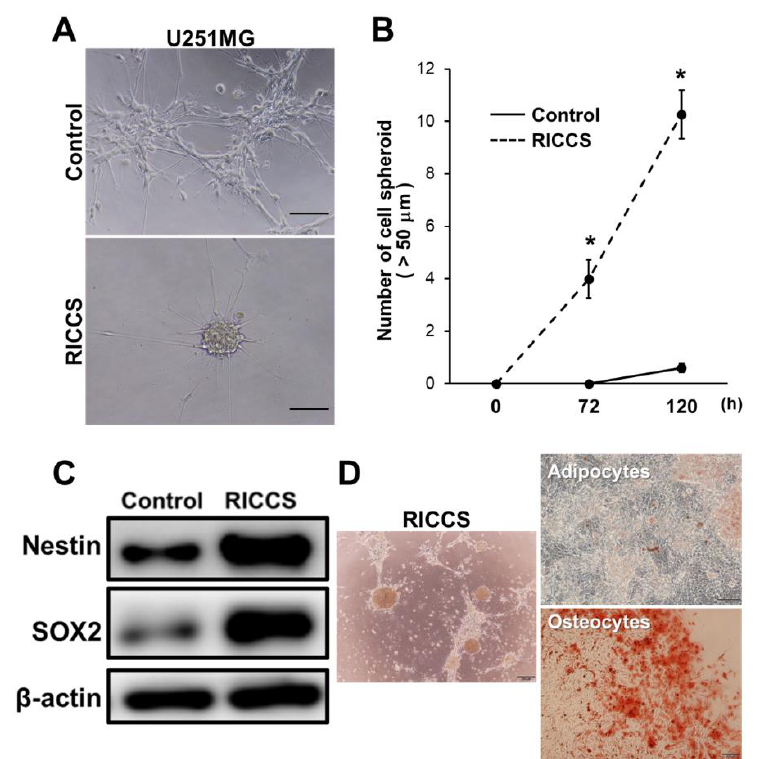
Figure 1. Ribosome incorporation into glioma cells induced stem cell characters. ( A ), Control (PBS) or ribosome-induced cancer cell spheroid (RICCS) in GBM (U251MG) cells. ( B ), Stem cell character was confirmed by sphere formation, and the graph showing the number of spheres (>50 µm) cultured for 0, 72, and 120 h. ( C ), Western blotting showing the stem cell markers, Nestin and SOX2 in RICCS. ( D ), Transdifferentiation of RICCS into adipocytes and osteocytes. RICCS from U251MG cells (let panel) and adipocyte and osteocyte transdifferentiation staining (right panel). Scale bar: 200 µm. * p < 0.05.